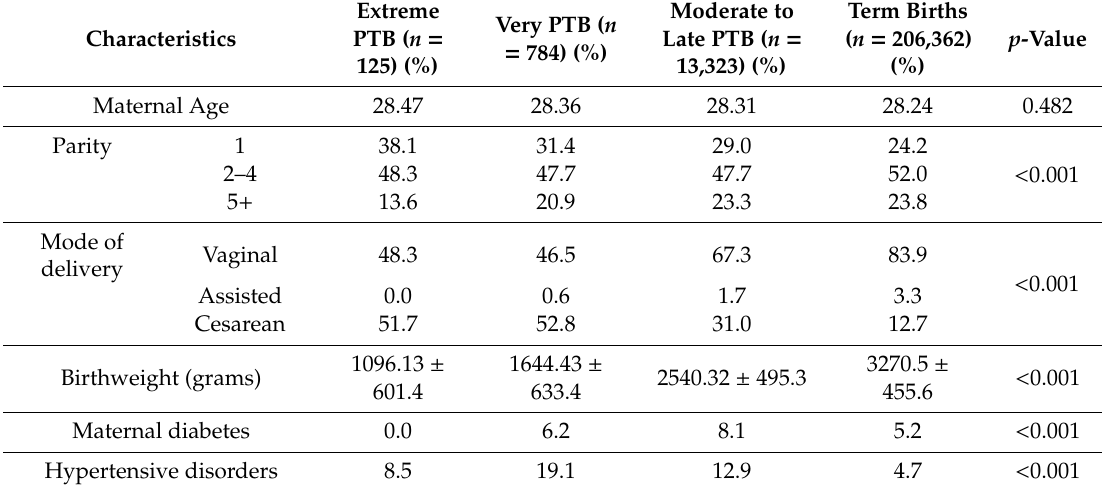
Table 1. Demographic characteristics of pregnancies according to gestational age at delivery.